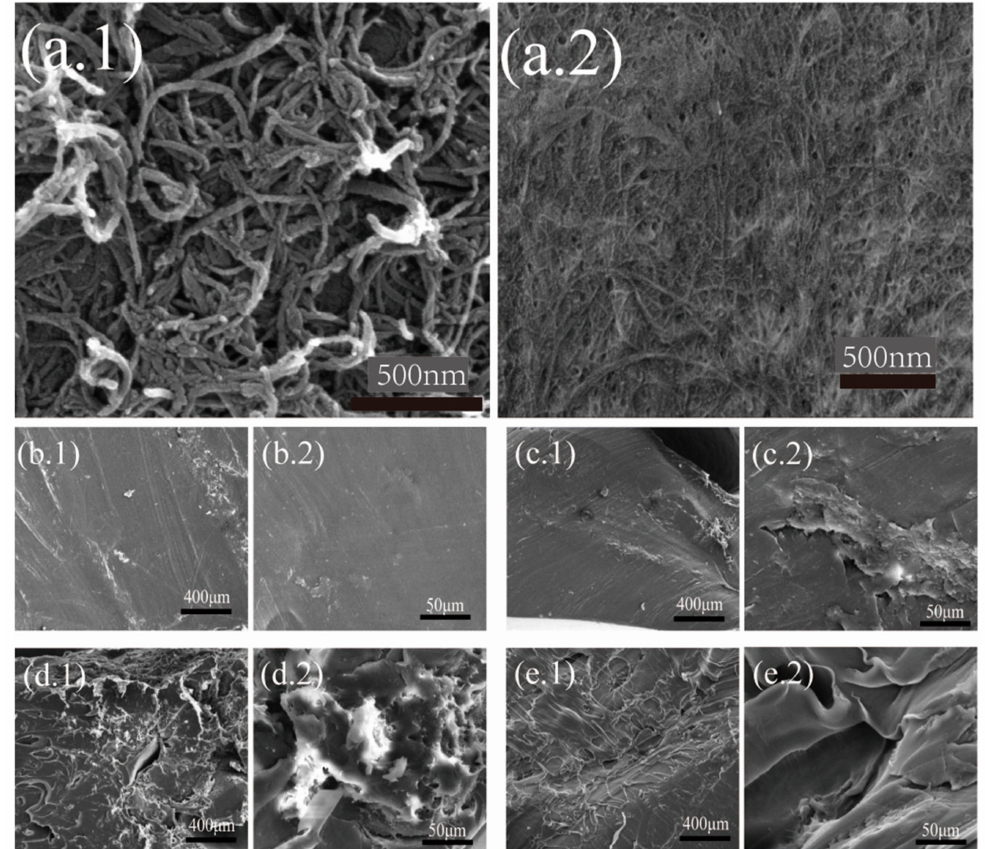
Figure 5. SEM images of ( a ) CNF prepared at ( a.1 ) a low stirring speed and ( a.2 ) 37,000 rpm; ( b ) pure PLA at ( b.1 ) low magnification and ( b.2 ) high magnification; ( c ) 1 wt.% AKD-CNF/PLA at ( c.1 ) low magnification and ( b.2 ) high magnification; ( d ) 2.5 wt.% AKD-CNF/PLA at ( d.1 )